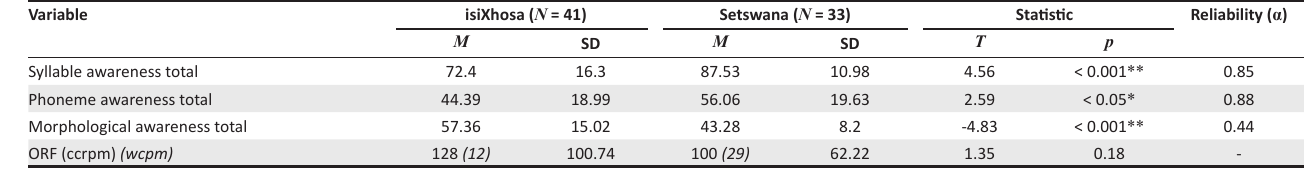
TABLE 4: Descriptive statistics: Syllable awareness, phoneme awareness, morphological awareness and oral reading fluency.